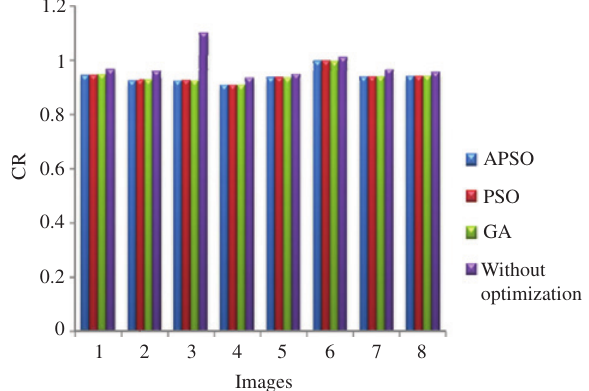
Figure 9: Comparison Ratio Comparison.